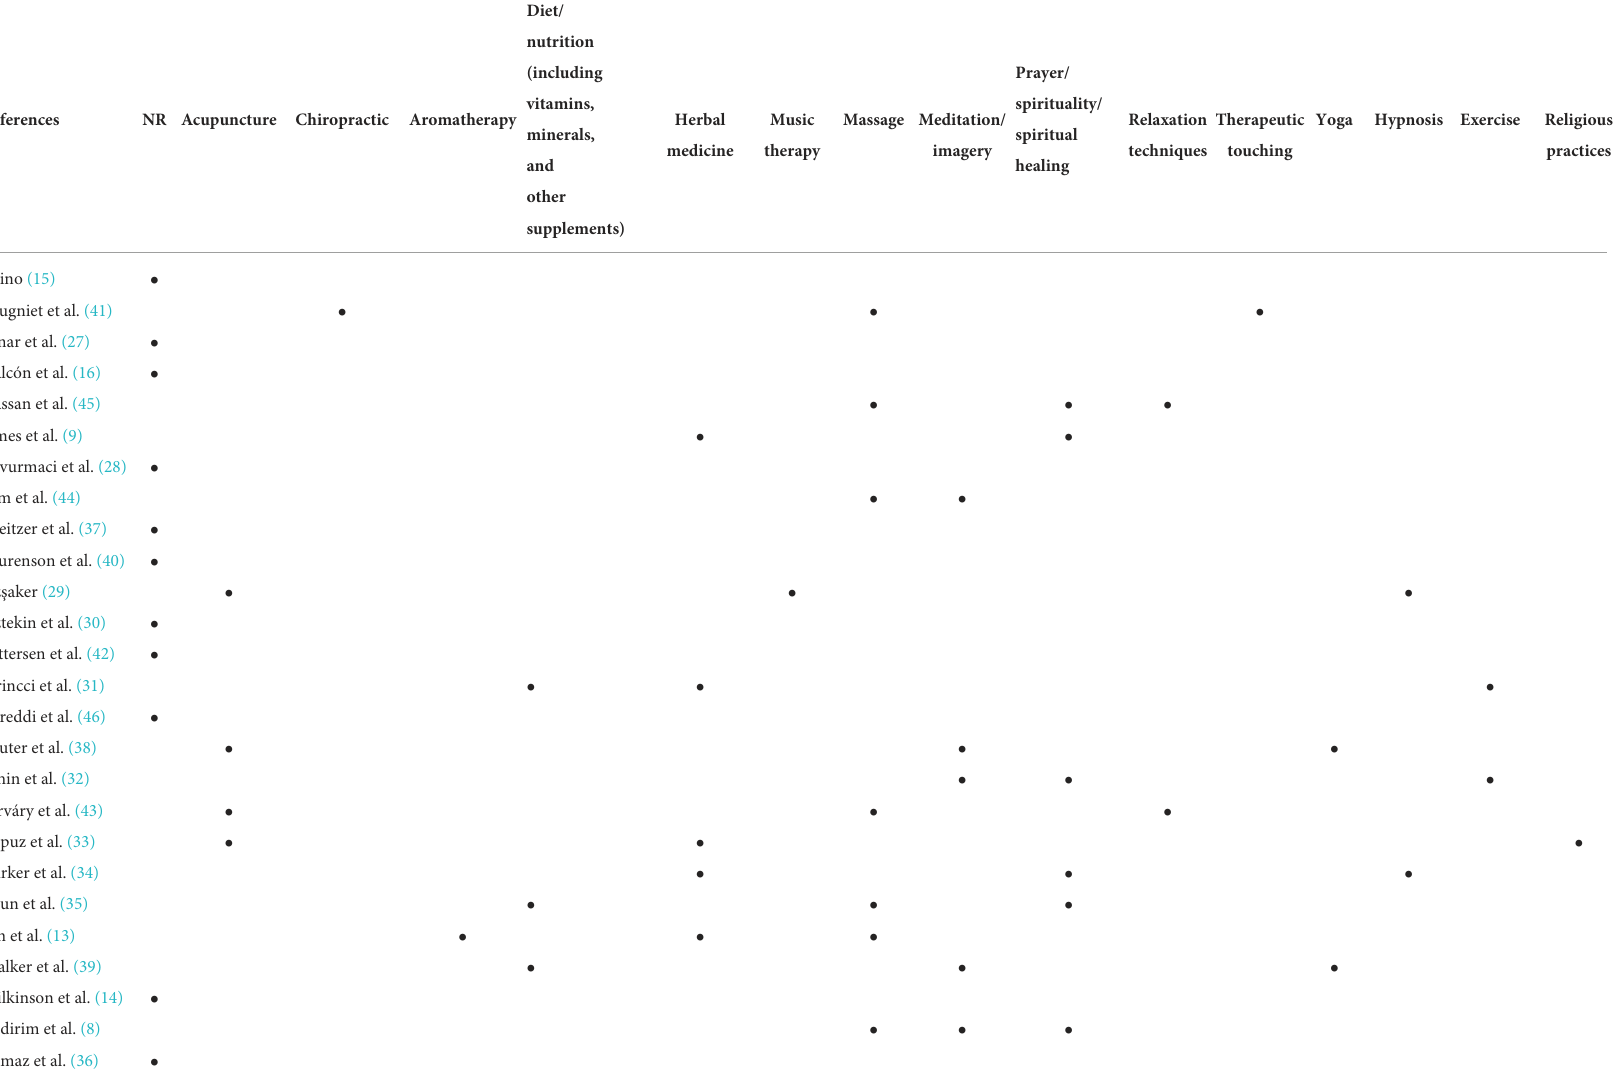
TABLE 4 Top three CAM modalities best known to nursing students in each